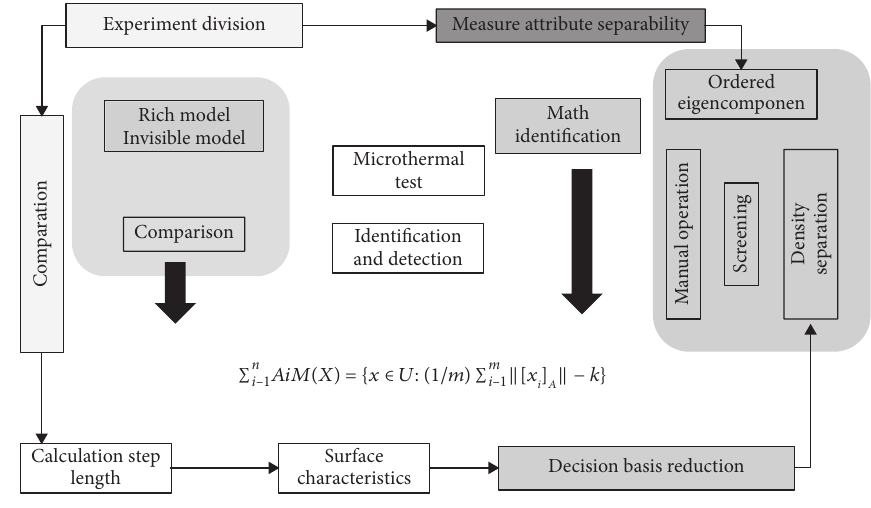
Figure 4: Average level decision